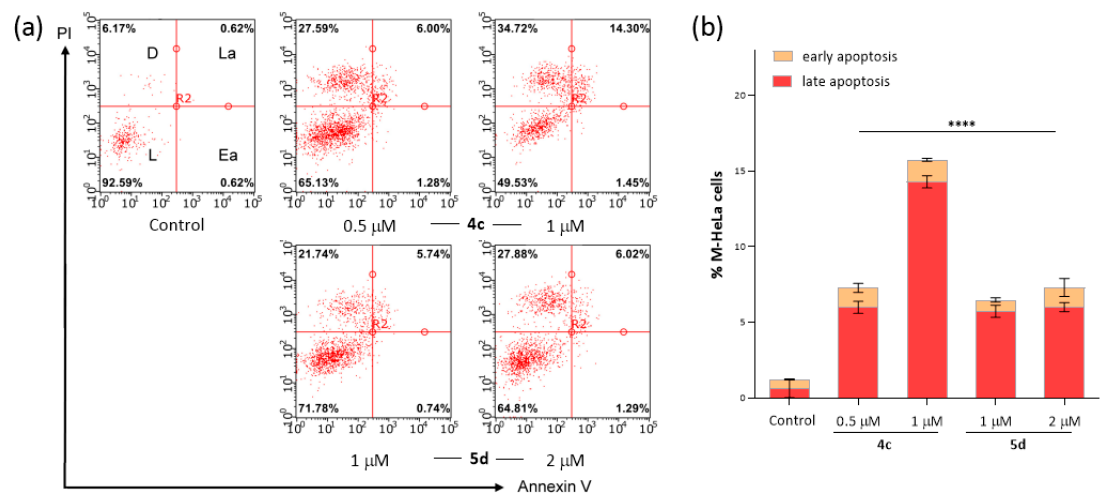
Figure 2. Induction of apoptosis in M-HeLa cancer cells by compounds 4c and 5d , evaluated by Flow Cytometry Assay, after cell labeling with propidium iodide (PI) and Annexin V- Alexa Fluor 647 ( a ). L, D, La and Ea labels in the top right control plot correspond to Live, Dead, Late apoptosis and Early apoptosis, respectively. Cells were either unlabeled and untreated (Control) or treated with IC 50 and IC 50 /2 doses of test compounds for 48 h, as indicated. The quantitative analysis of early and late apoptotic cells after drug exposure is represented in ( b ). Data are presented as mean ± error of the mean ( n = 3). **** p ≤ 0.0001 compared to control (one-way ANOVA). Concentration for 4c was (IC 50 /2- 0.5 µ М and IC 50 - 1.0 µ М ); for 5d (IC 50 /2- 1.0 µ М and IC 50 - 2.0 µ М ).